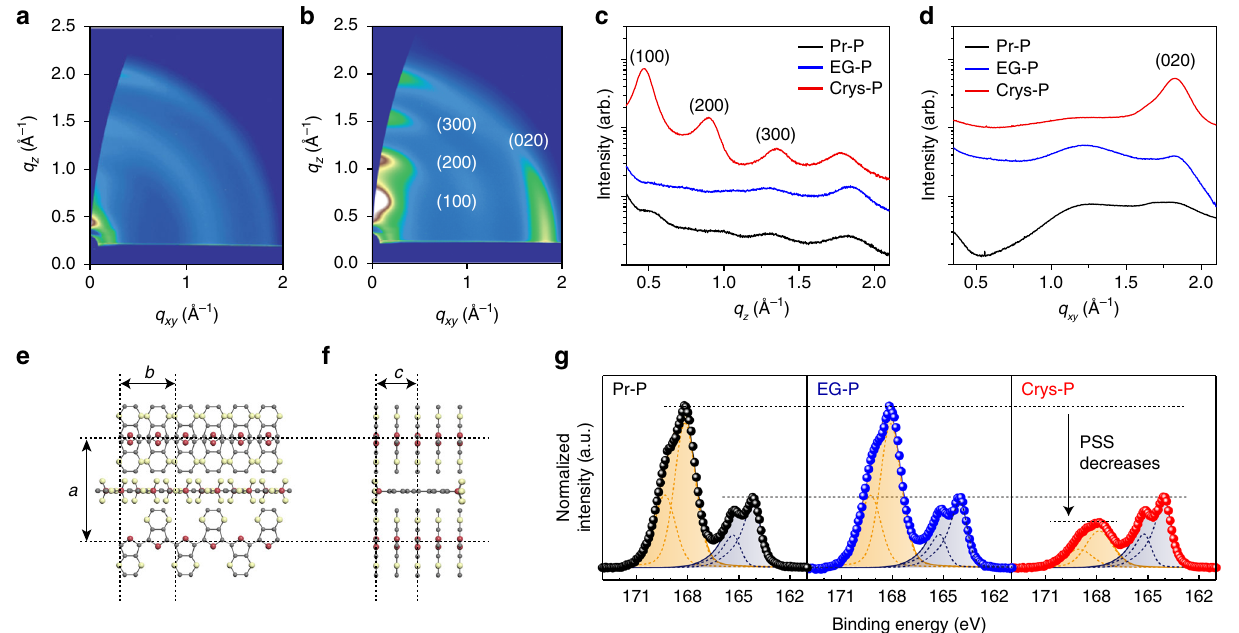
Fig. 2 Film microstructures and compositions in PEDOT:PSS fi lms. a Two-dimensional grazing incidence wide-angle x-ray scattering (GIWAXS) patterns obtained for 5% ethylene glycol-treated PEDOT:PSS (EG-P) and b crystallized PEDOT:PSS (Crys-P) fi lms. c Vertical and d horizontal GIWAXS pro fi les of pristine PEDOT:PSS (Pr-P), EG-P, and Crys-P fi lms, where q z and q xy are the perpendicular and parallel wave vector transfers with respect to sample surface, respectively. e , f A schematic illustration of the proposed polymer chain arrangement in the Crys-P fi lm in ( e ) the c-axis and ( f ) the b-axis directions. The a-axis direction is perpendicular to the substrate surface (a-axis direction). g X-ray S 2p photoelectron spectra of Pr-P, EG-P, and Crys-P fi lms. The deconvoluted pro fi les were fi tted with two symmetric/asymmetric Gaussian-Lorenzian functions representing sulfur atoms from styrene sulfonate (SS, yellow gradients) and EDOT thiophene (EDOT, navy gradients) a